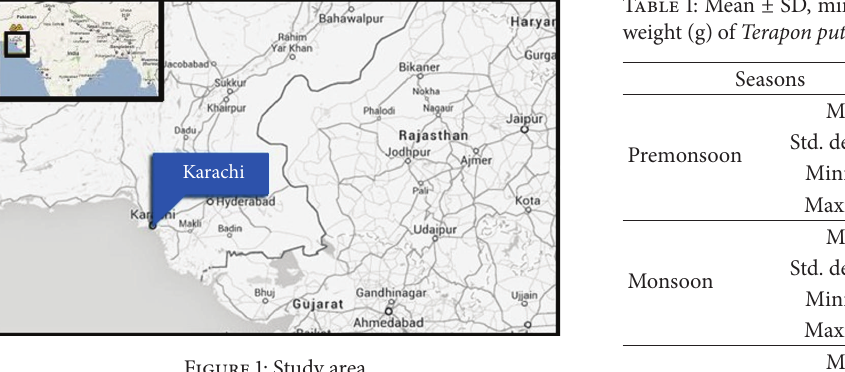
Figure 1: Study area.